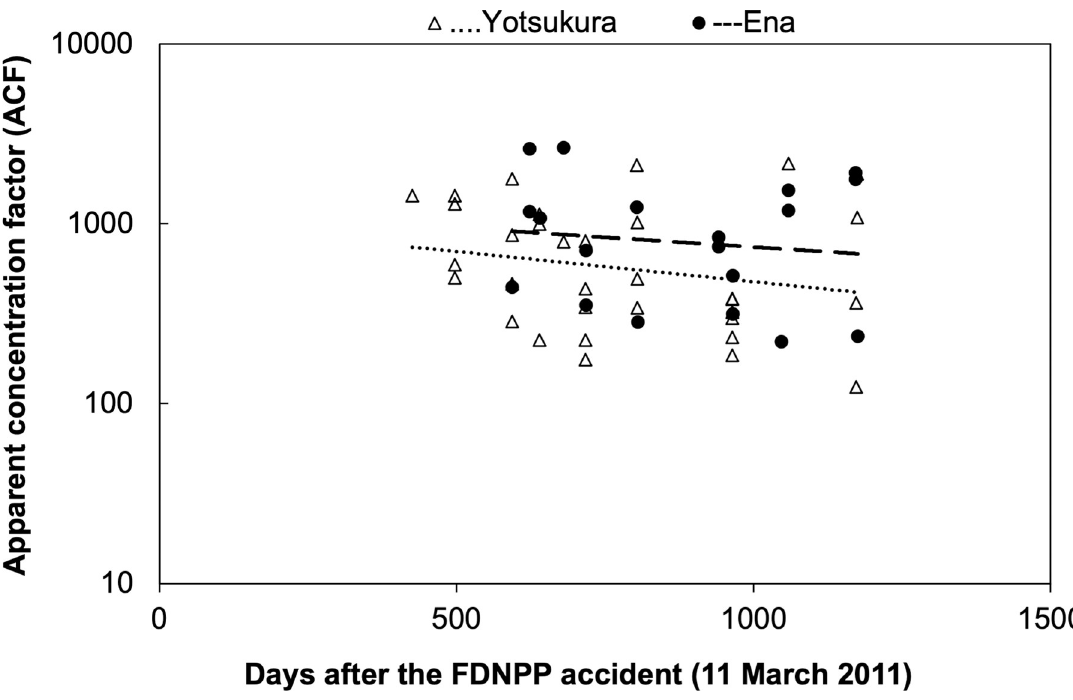
Fig 4. Spatial and temporal variations in the apparent concentration factor (ACF) of 137 Cs in sea urchins. Dashed lines represent statistically insignificant regression slopes.